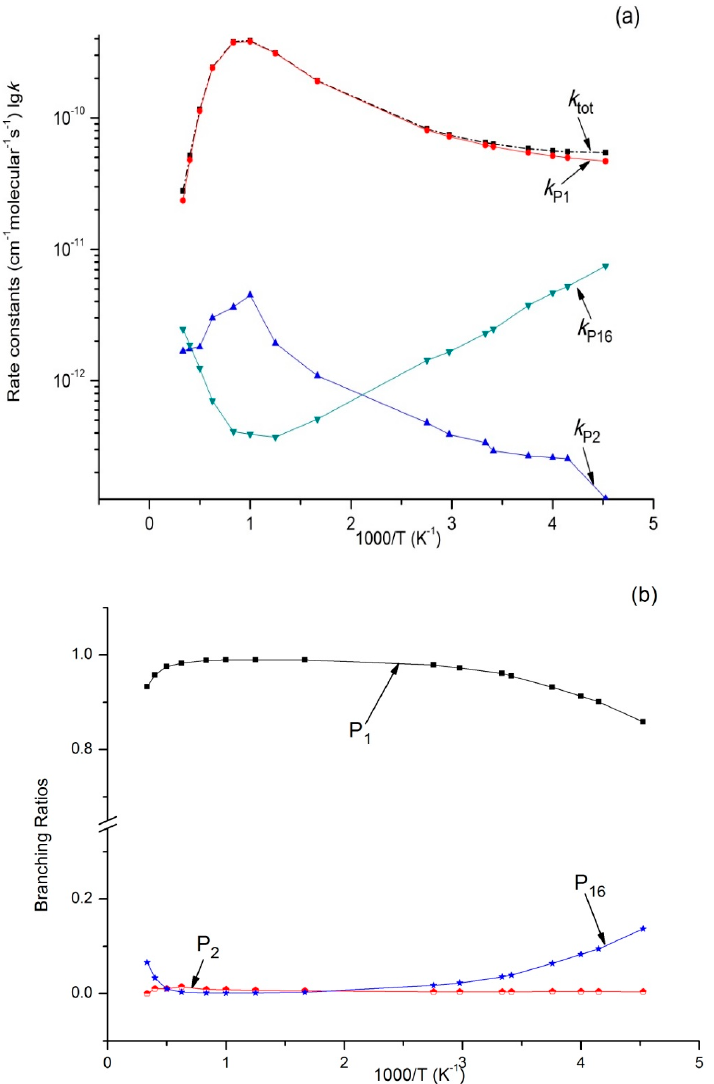
Figure 4. ( a ) Rate constants of total ( k tot ) and various reaction channels ( k P1 , k P2 , k P16 , and k IM1 ) at 1 × 10 − 4 Bar in a temperature range of 220 K to 3000 K; ( b ) Branching ratios of various reaction channels at 1 × 10 − 4 Bar in a temperature range of 220 K to 3000 K.